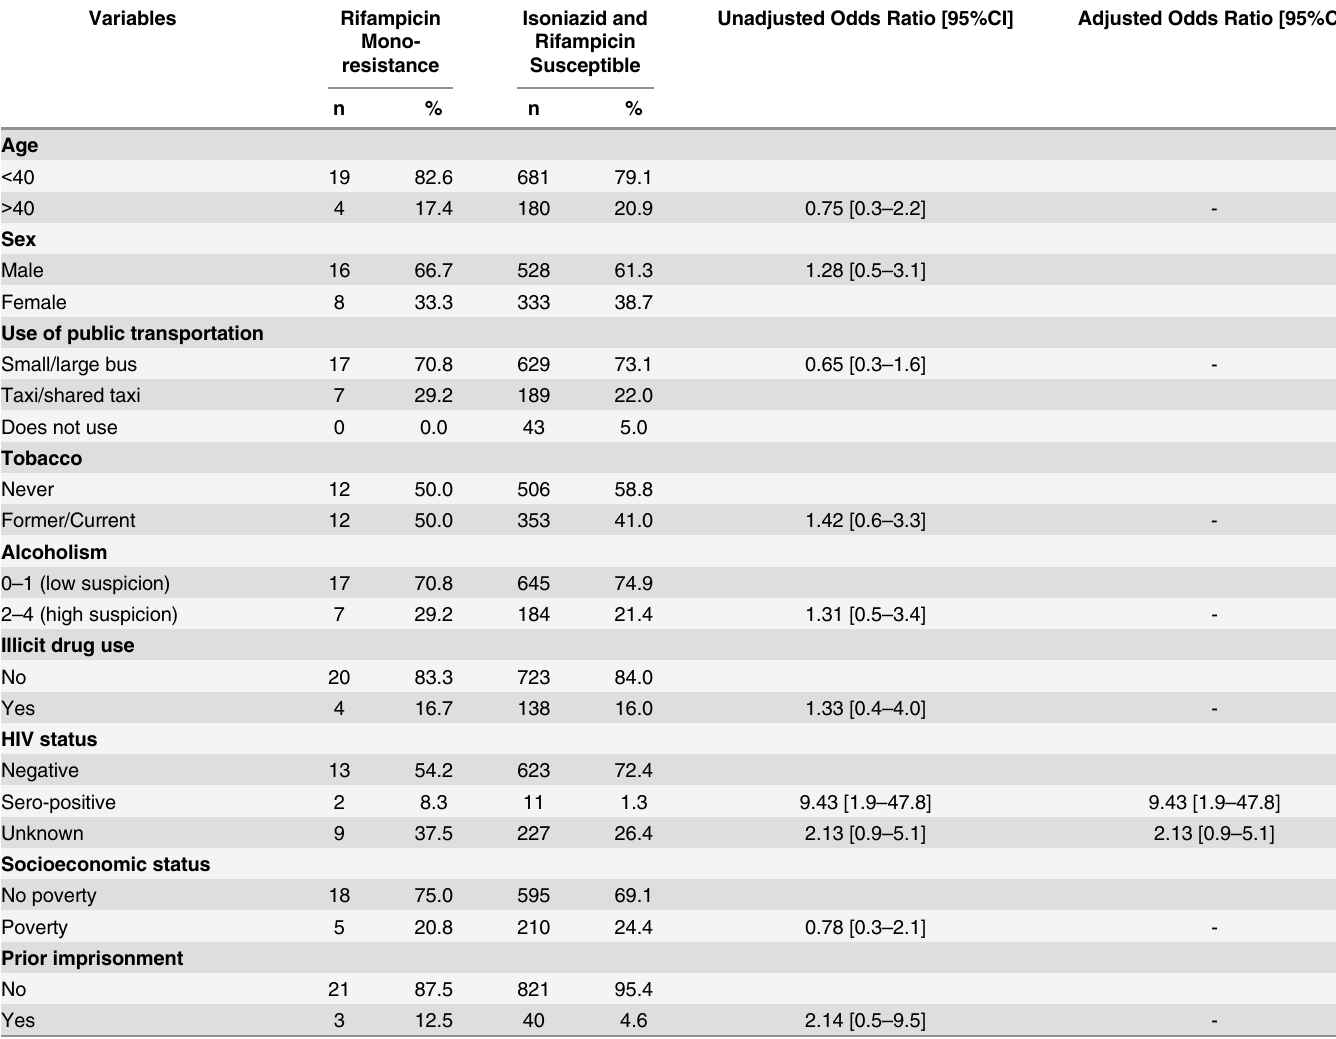
Table 3. Multivariate Analysis of Characteristics Associated with Rifampicin